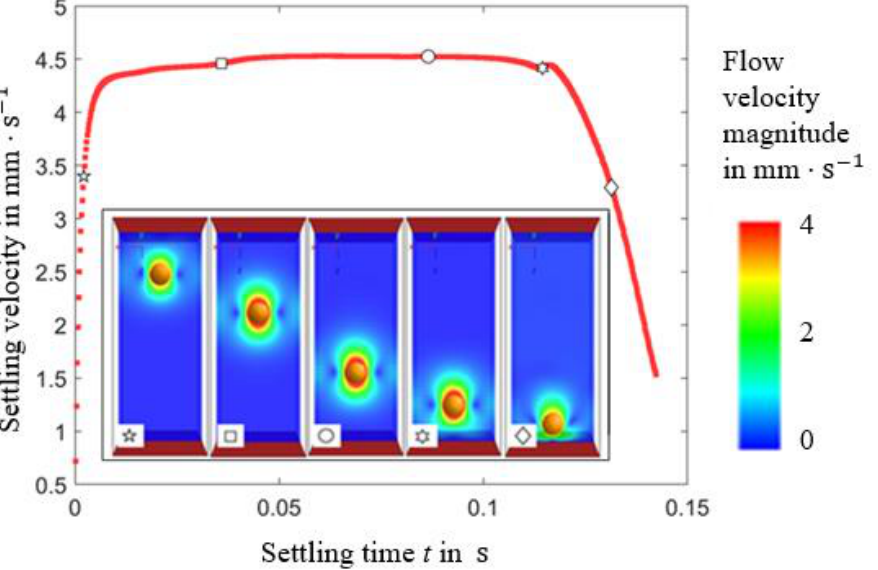
Figure 11. Particle settling velocity with the corresponding images at characteristic time points of sedimentation obtained in the simulation case A1.